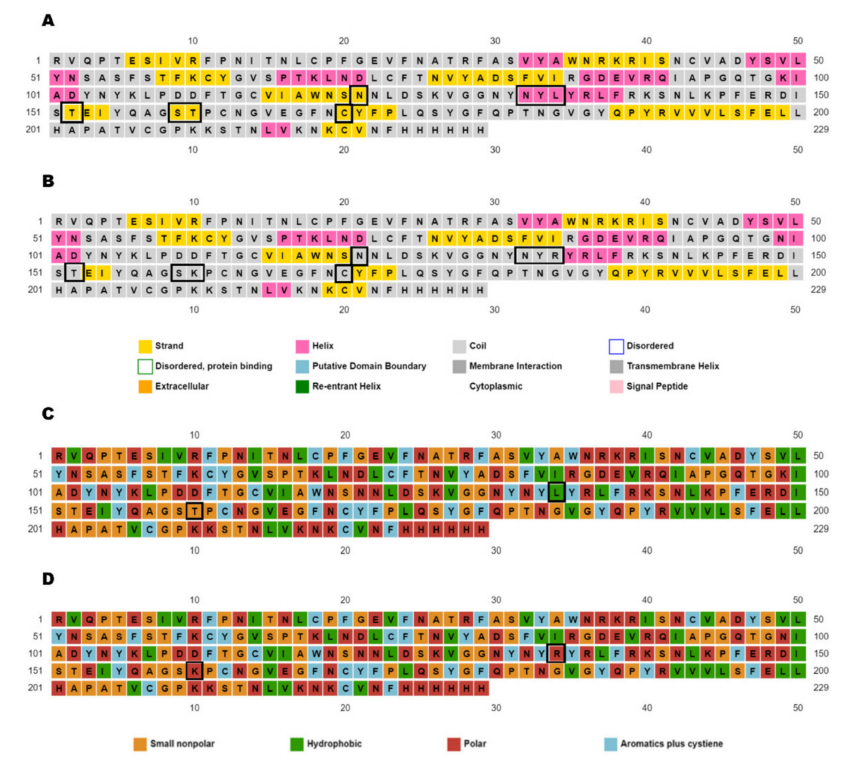
Figure 4. Secondary structure prediction output given by PSIPRED for S RBD of ( A ) wild-type and ( B ) Delta forms of SARS-CoV-2. ( C , D ) represent the changes in the formation of secondary structural elements between the two protein sequences due to amino acid substitutions, and deletions are highlighted in the black